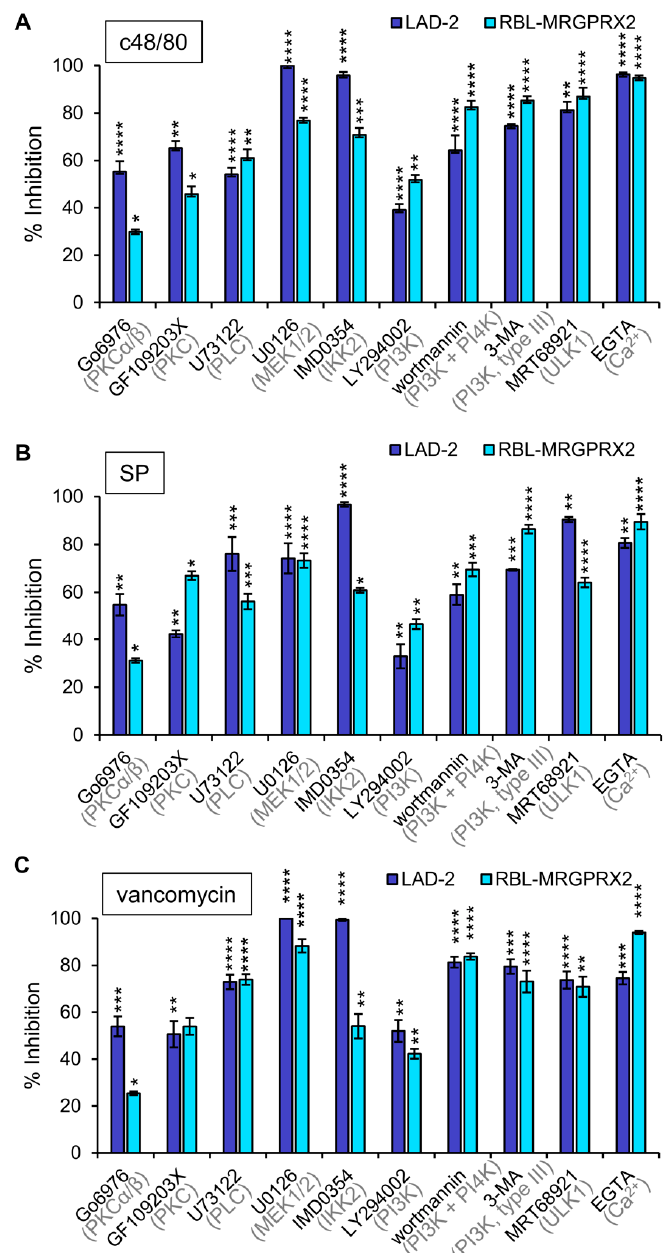
Figure 5. Inhibitor profiling of MRGPRX-2-induced secretion in LAD-2 and RBL-MRGPRX2 cells reveals similar patterns of drug sensitivity. RBL-MRGPRX2 and LAD-2 cells were incubated for 30 min with vehicle or 1 μ M Go6976, 1 μ M GF109203X, 10 μ M U73122, 10 μ M U0126, 0.5 μ M IMD0354, 10 μ M LY294002, 50 μ M wortmannin, 5 mM 3-MA, 1 μ M MRT68921 or 2 mM EGTA, as indicated. Cells were then stimulated by either 1 μ g/mL c48/80 ( A ), 10 μ M SP ( B ) or 1 mg/mL vancomycin ( C ), for a further 30 min. Release of β -hexosaminidase was determined, and percent of inhibition was calculated and compared for the two cell types, as indicated. Data are the means ± SEM of 5–10 separate experiments. Statistical significance was determined by one-way ANOVA, followed by Dunnett’s post-test (* p < 0.05, ** p < 0.01, *** p < 0.001 and **** p < 0.0001).